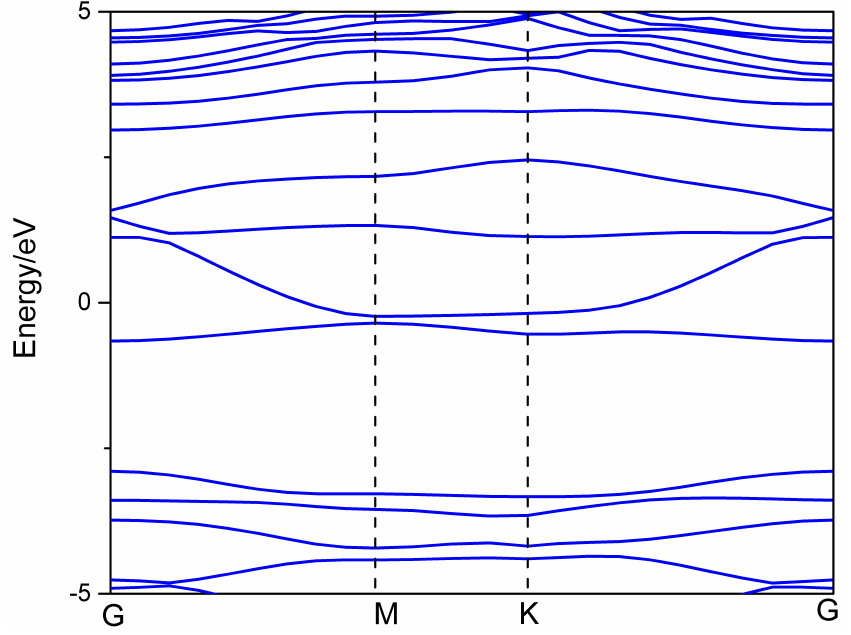
Figure 6. Band structure of the Al − decorated g − C